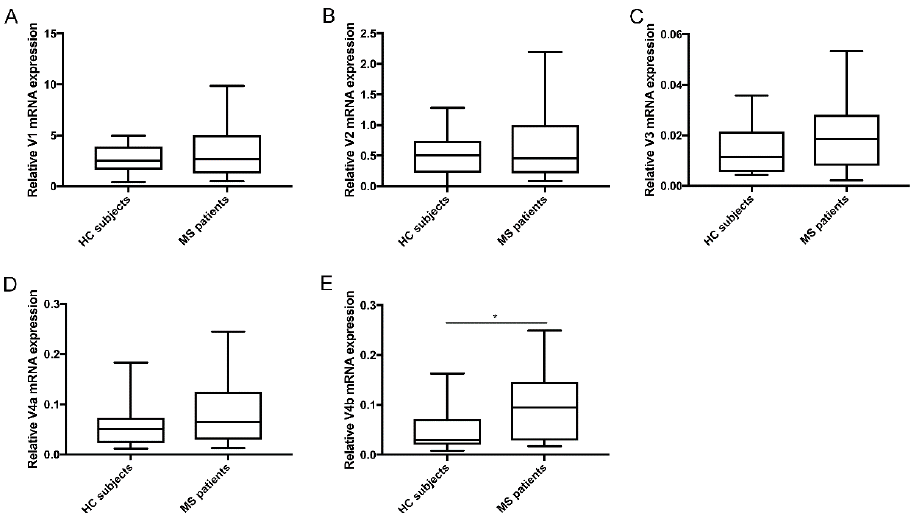
Figure 1. mRNA levels of TG2 isoforms in PBMCs derived from PP-MS patients and HC subjects. qPCR analysis was performed to detect ( A ) V1 mRNA (HC: N = 30/PP-MS: N = 22); ( B ) V2 mRNA (HC: N = 30/PP-MS: N = 22); ( C ) V3 mRNA (HC: N = 18/PP-MS: N = 12); ( D ) V4a mRNA (HC: N = 24/PP-MS: N = 20) and ( E ) V4b mRNA (HC: N = 23/PP-MS: N = 18) in primary human peripheral blood mononuclear cells (PBMCs) isolated from PP-MS patients and HC subjects. Data are normalized relative to the geometric mean of the mRNA levels HPRT1 and POLR2F. mRNA and are shown in box-and-whiskers plots in which the median is represented by a horizontal line within the box and the lower and upper whiskers represent the min and max value. * p < 0.05. MS = Multiple sclerosis, HC = Healthy